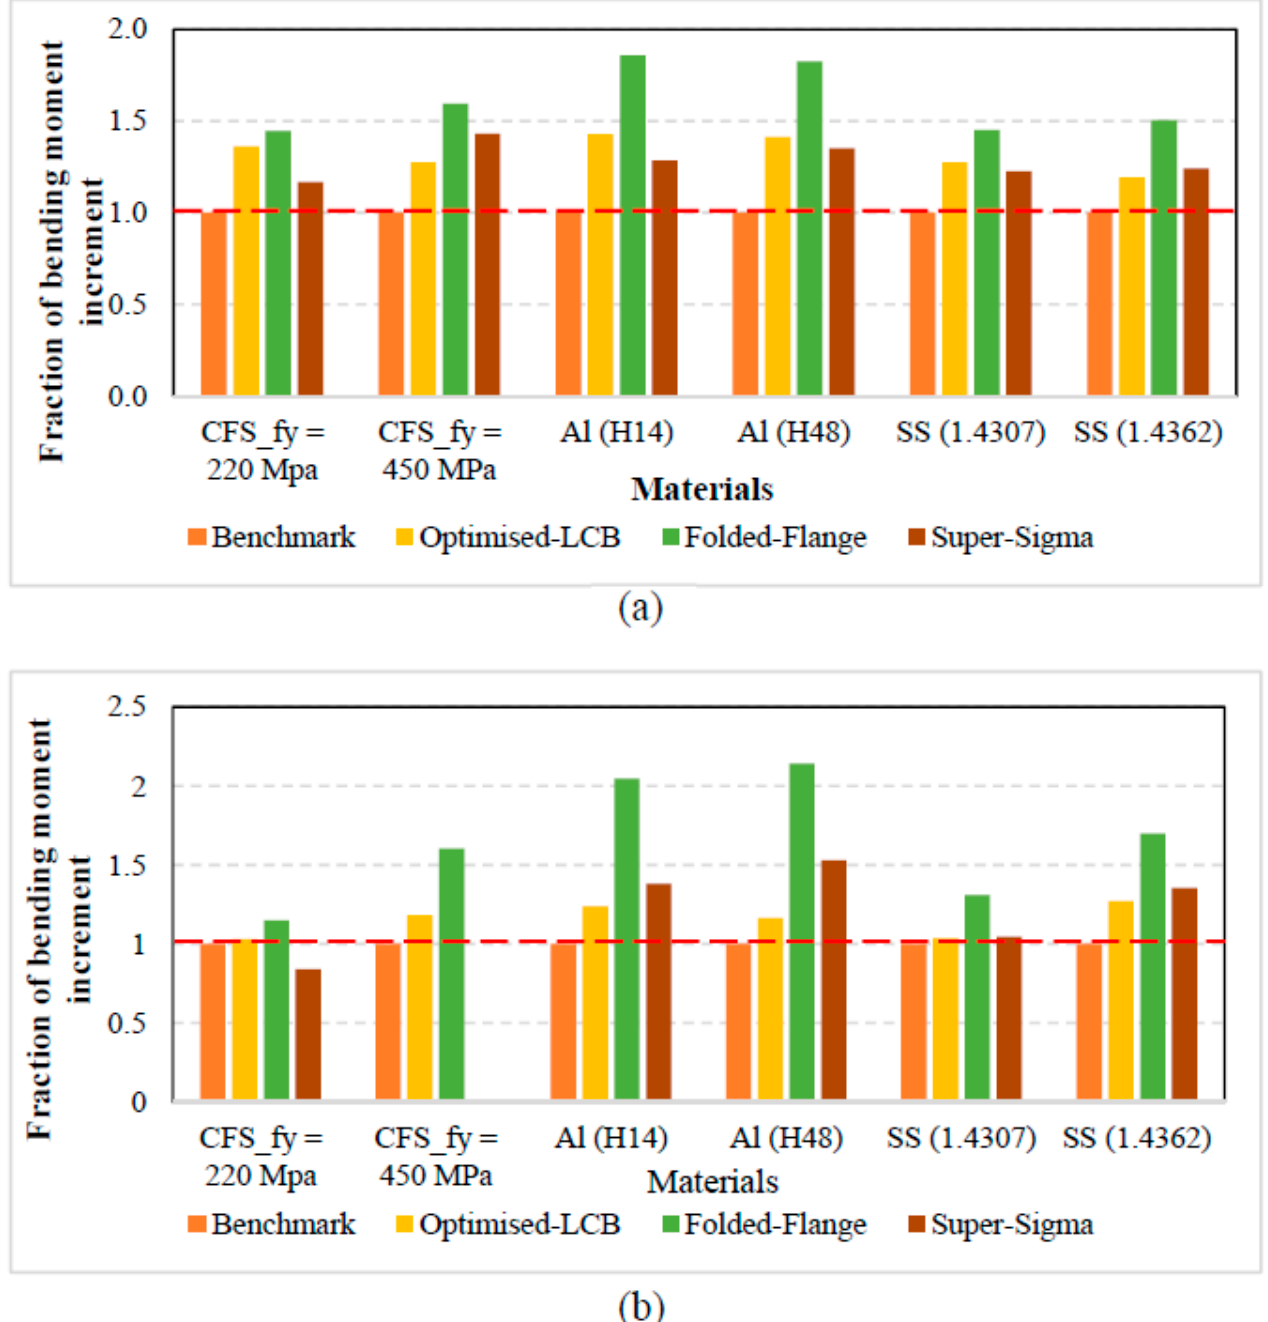
Figure 16. Bending moment capacity increment for different ( a ) single and ( b ) built-up sections based on benchmark section.